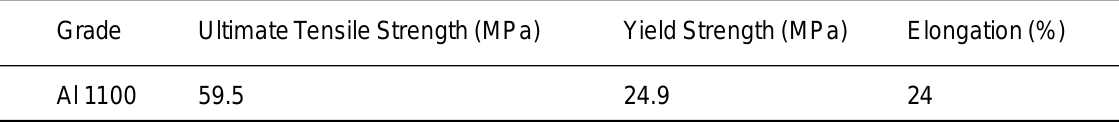
Table 2. The mechanical properties of the sheets